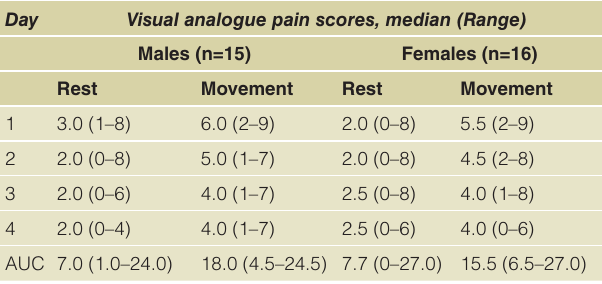
Table 2. Median post-operative pain scores and Area Under the Curve (AUC) at rest and on movement by gender, days 1–4. Day Visual analogue pain scores, median (Range) Males